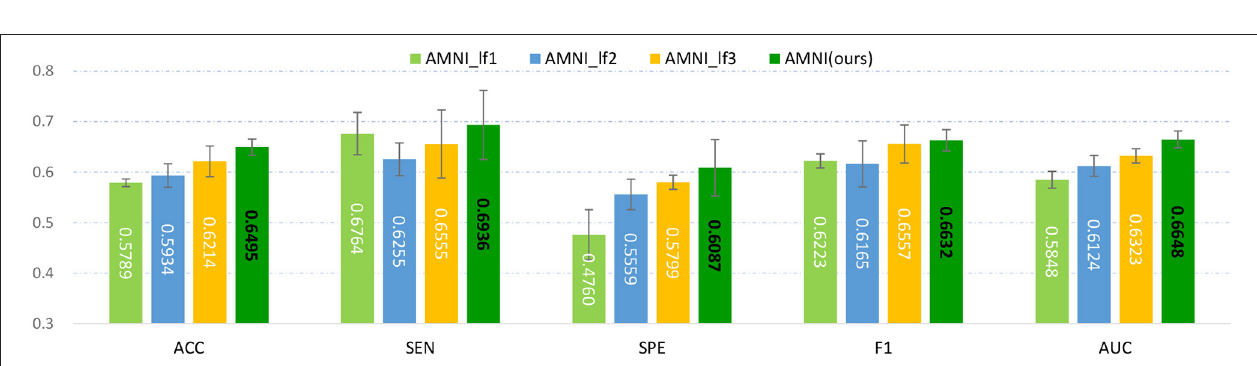
, 0.5 , and 0.8 , 0.8 0.5 0.2